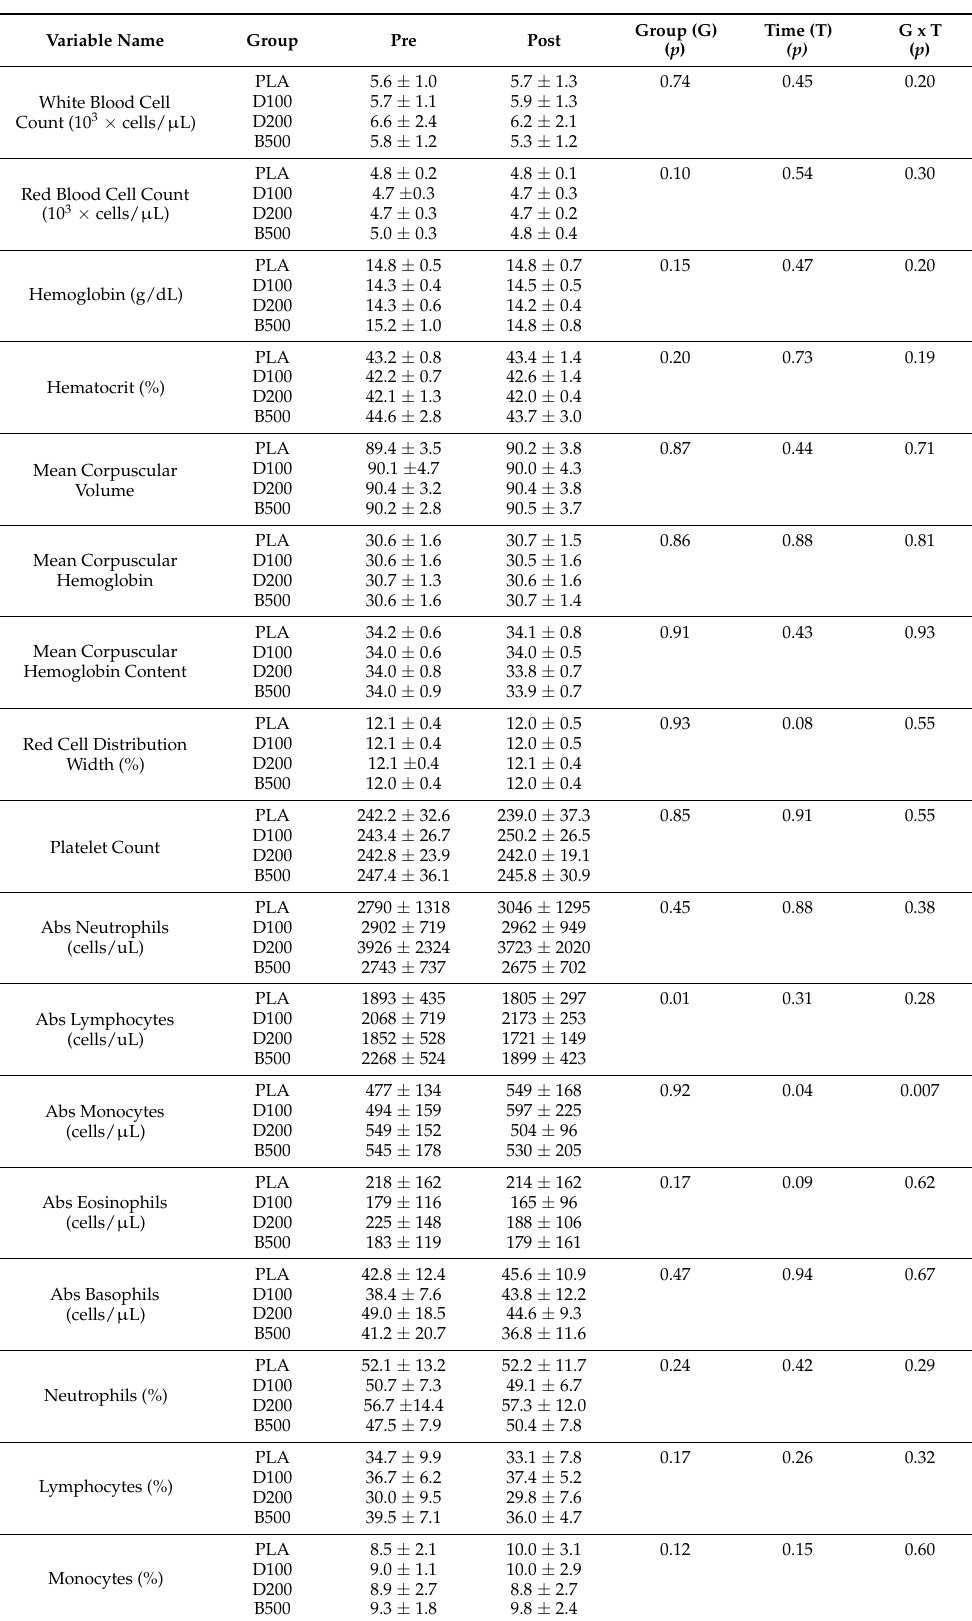
Table 6. Complete blood